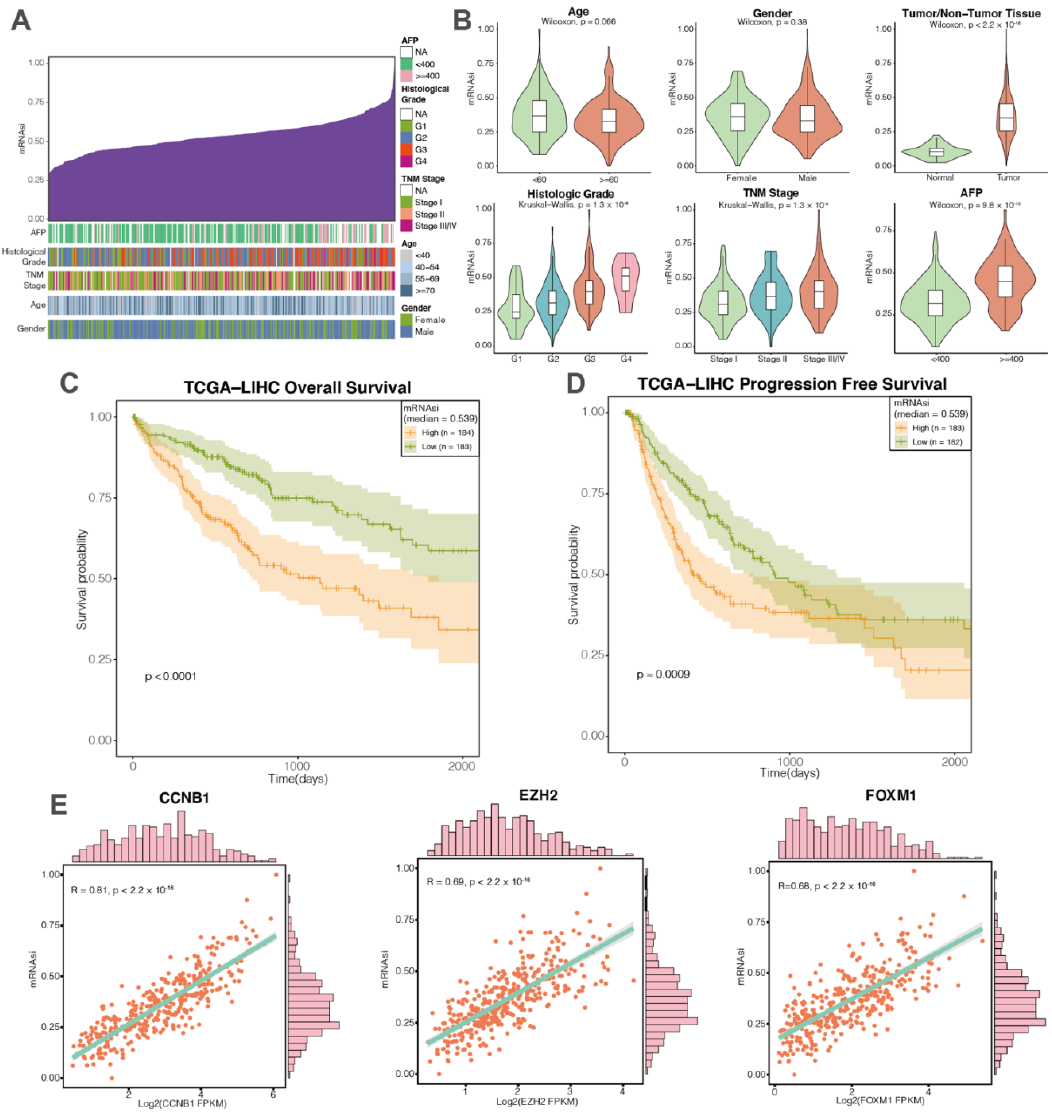
Figure 2. Clinical and molecular features associated with the mRNAsi in HCC patients. ( A ) Overview of the association between mRNAsi and clinical features of HCC patients. Columns represent samples sorted by mRNAsi. Rows represent clinical features associated with mRNAsi. ( B ) Violin plots of mRNAsi of the HCC patients classified by age, sex, histological grade, TNM stage, and AFP levels. The mRNAsi of tumor tissues and paratumoral normal tissues are also displayed. ( C , D ) High mRNAsi correlated with significantly poor overall survival (OS) and recurrence-free survival (RFS) (log-rank test, p < 0.0001 and p = 0.0009, respectively). ( E ) Positive association of mRNAsi with several well-characterized cancer stemness regulators (i.e., CCNB1, FOXM1, and